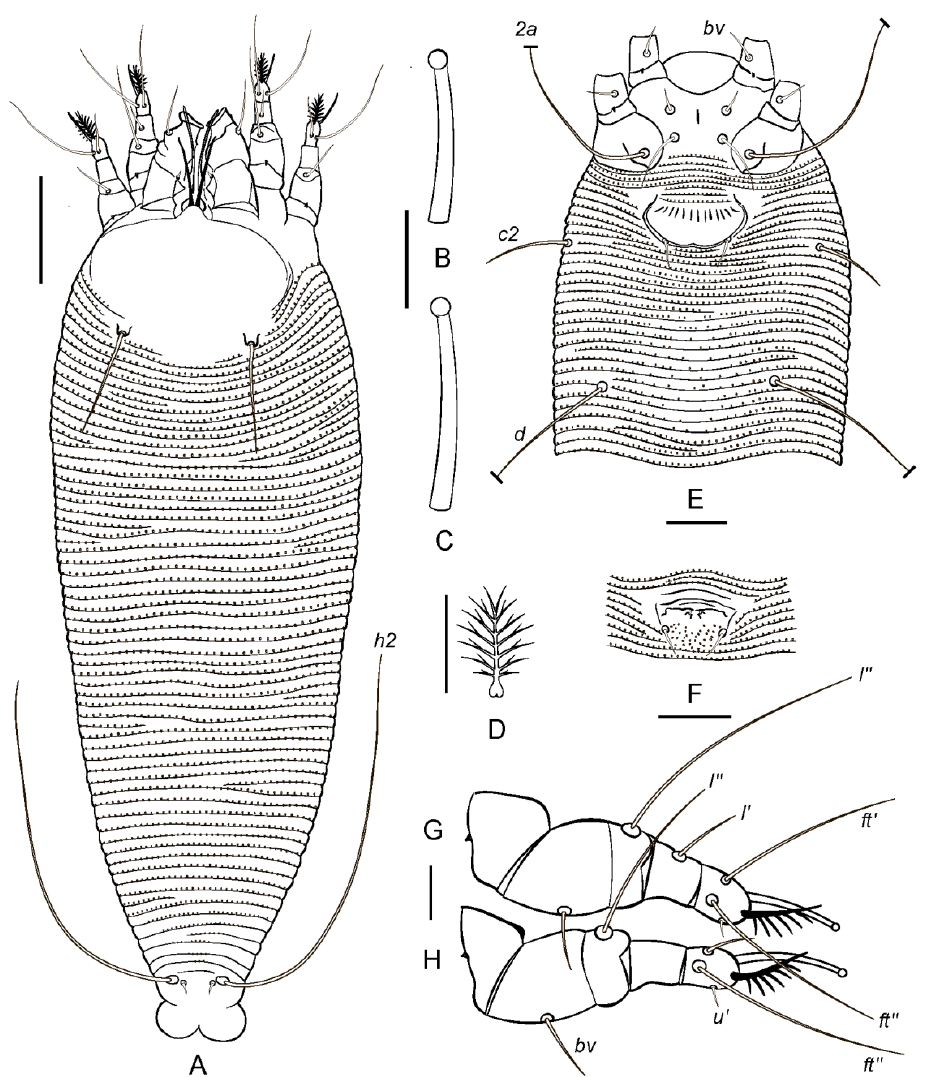
Figure 7. Drawings of female (all except F) and male (F) of Aberoptus schotiae n. sp. (morphotype B). ( A )—dorsal view of entire female, ( B , C )—tarsal solenidia I and II, ( D )—empodium I, ( E )—female cox- igenital area; ( F )—male genital area; ( G , H )—legs I and II. Scale bar: ( A ) = 30 µ m; ( B – D , G , H ) = 5 µ m; ( E , F ) = 15 µ